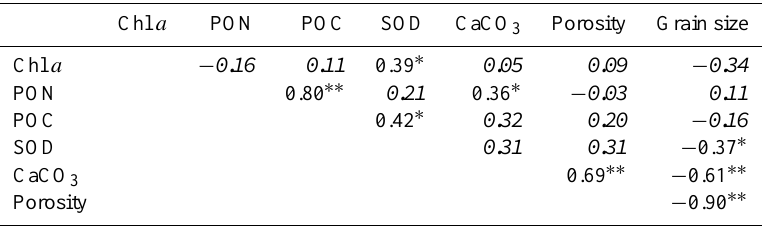
Table 3. Correlation matrix of environmental sedimentary parameters. Significance levels of correlation coefficients (Spearman’s rank cor- relation) among sedimentary parameters and distance from Santa Marta are indicated by asterisks with ∗ for significant ( p < 0.05) and ∗∗ for very significant ( p < 0.01). Not significant correlations are displayed in italics. Abbreviations as previously defined in Table 1 and sediment oxygen demand (SOD).